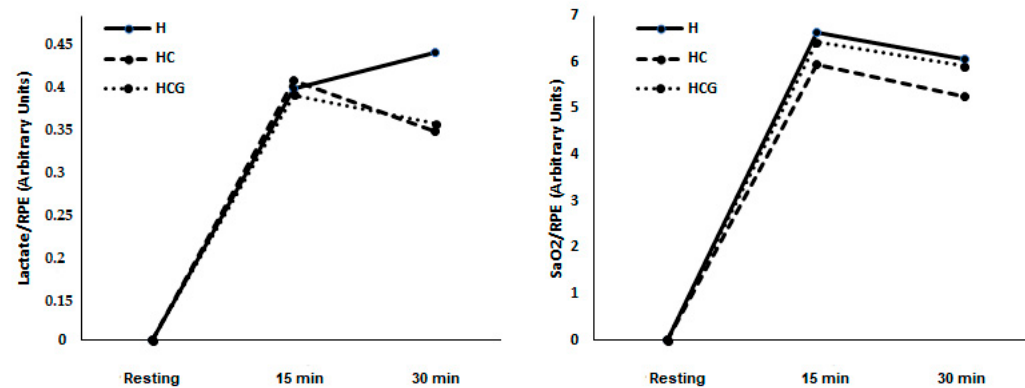
Figure 3. Lactate / RPE ratio and SpO 2 % / RPE ratio demonstrated as a mean. Two-way ANOVA and Tukey’s test were used, n = 9 volunteers. For p < 0.05. Hypoxia (H), hypoxia + carbohydrate (HC), and hypoxia + carbohydrate + glutamine (HCG).